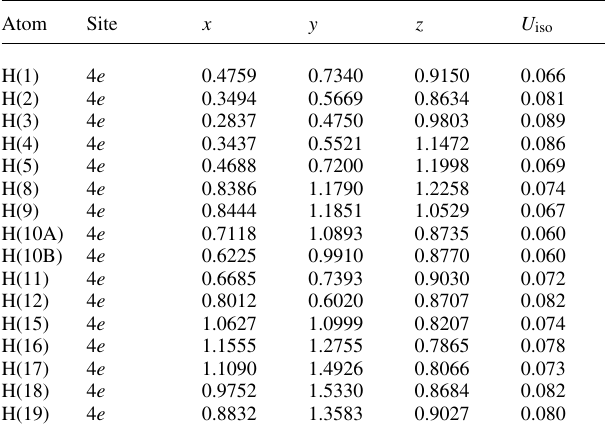
Table 2. Atomic coordinates and displacement parameters (in Å 2 )